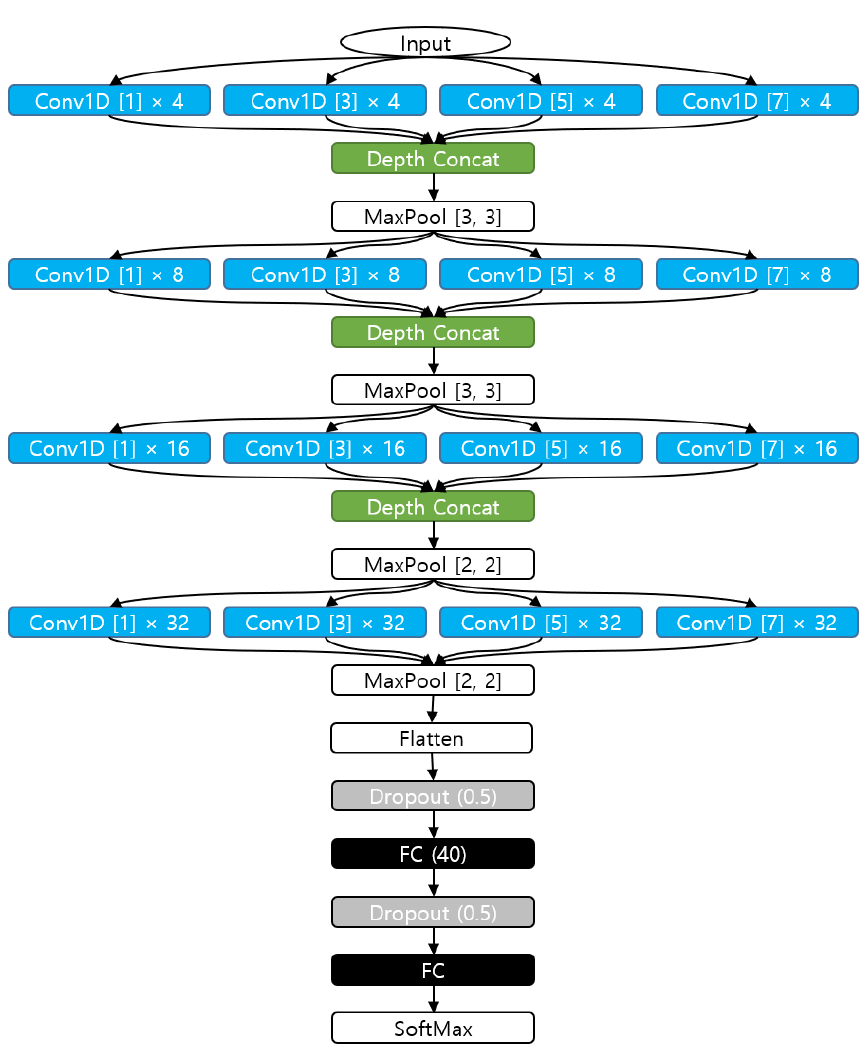
Figure 9. Proposed network structure. Conv1D[N].